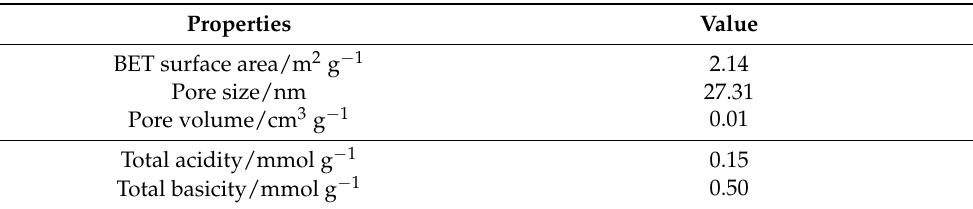
Table 2. BET surface area, total acidity, and total basicity of BCR measured by TPD–NH 3 and TPD–CO 2